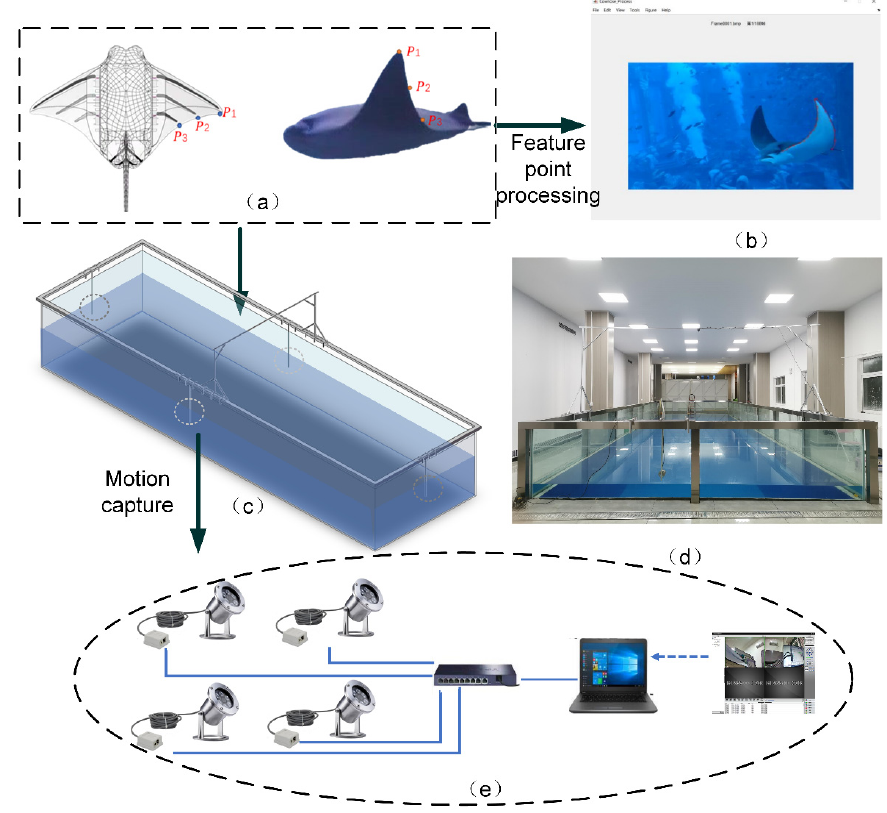
Figure 6. Experimental system for similarity evaluation of manta ray robot. ( a ) The graph of feature point selection; ( b ) Feature point processing software interface; ( c ) Schematic diagram of the experimental setup; ( d ) Physical diagram of the experimental setup; ( e ) Schematic diagram of underwater camera connection.